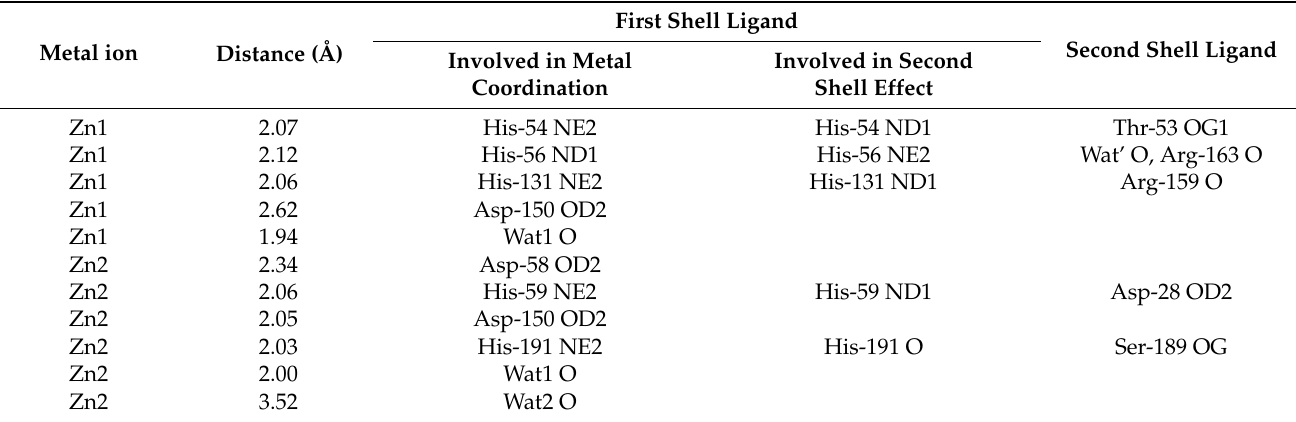
Figure 5. Crystal structure of BLEG-1 solved at 1.44 Å resolution. ( A ) Overall structure of BLEG-1 with marked secondary structure element; ( B ) zinc coordination in active site of BLEG-1 with labelled amino acid residues, zinc ions, and water molecules colored in CPK scheme; ( C ) second shell ligands of the metal binding site of BLEG-1. The metal ligands are labelled and colored in CPK scheme, while carbon atoms of the second shell ligands are illustrated in purple. Table 3. Coordination of zinc ions at active site of